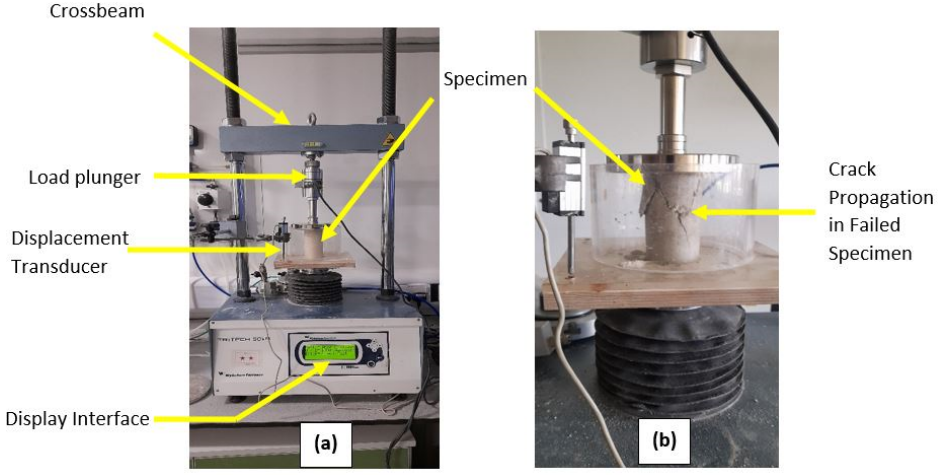
Figure 4. Gypseous soil sample in UCS testing. ( a ) UCS Test Set-up ( b ) Failed Sample in UCS Test